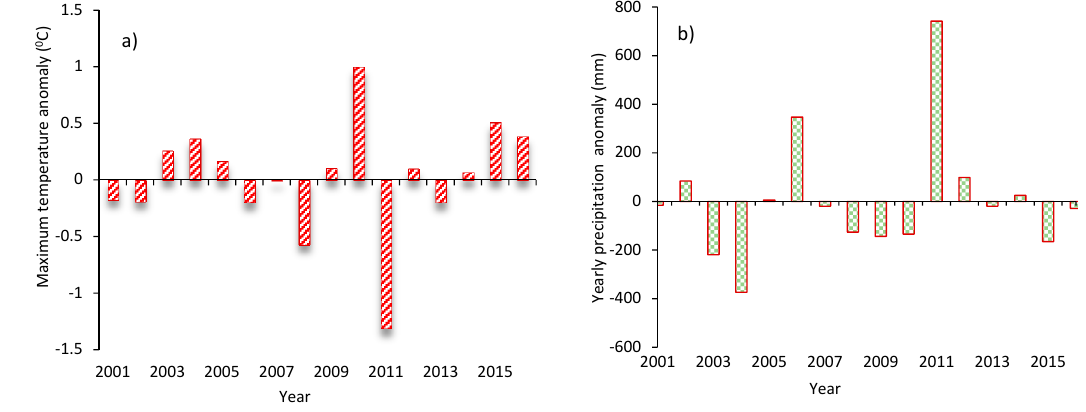
Figure 5. Annual maximum temperature anomaly ( a ) and precipitation anomaly ( b ) at Lampang station during 2001–2016.